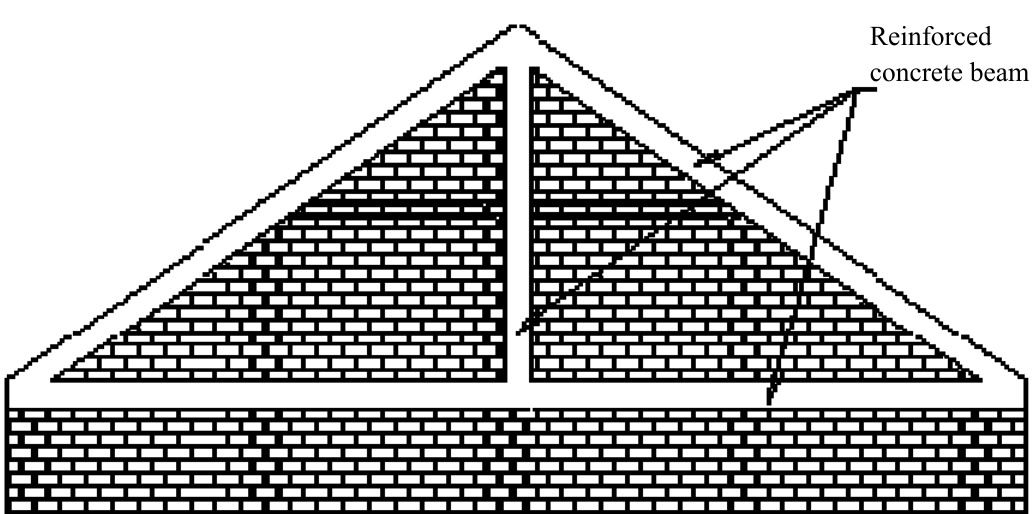
Figure 12. Recommended reinforced concrete elements for gable